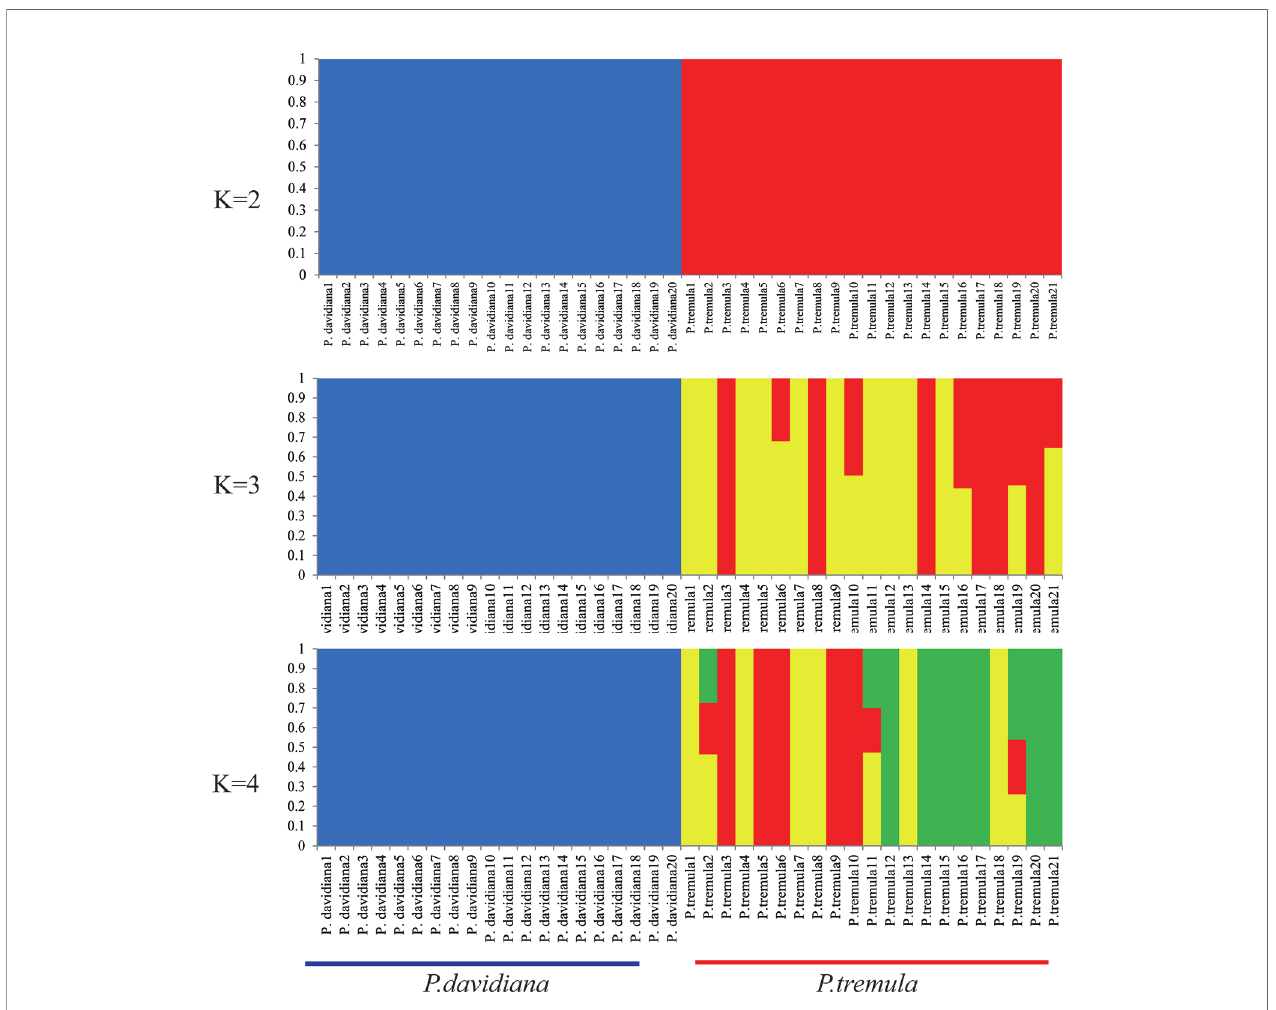
FIGURE 1 | Genetic structure of P. davidiana and P. tremula inferred using